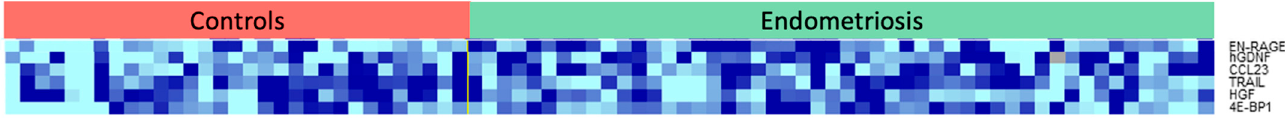
Figure 1. Heat map representing the target proteins that showed a significantly different concentration in plasma of patients with endometriosis (patients with DIE and patients with endometriosis without DIE) compared to controls. The color intensity correlates with the expression level of the protein.